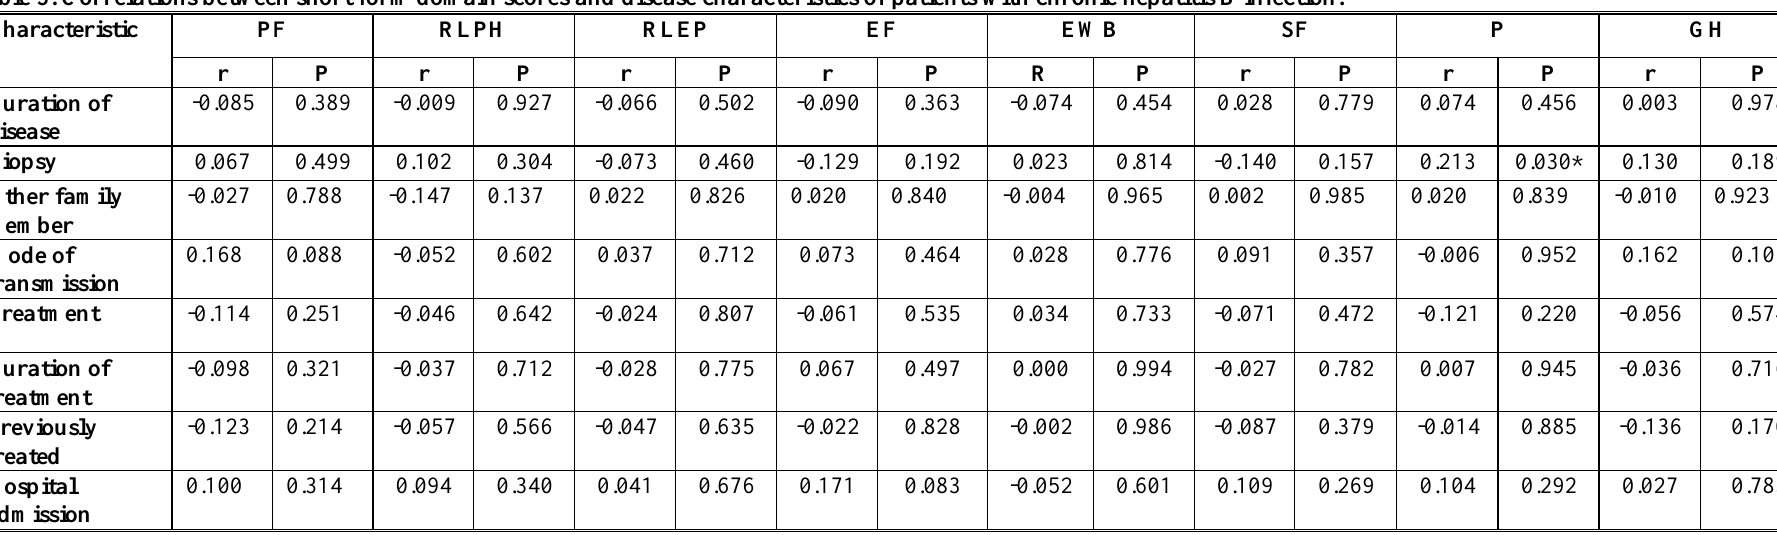
Table 5. Correlations between short form domain scores and disease characteristics of patients with chronic hepatitis B infection.